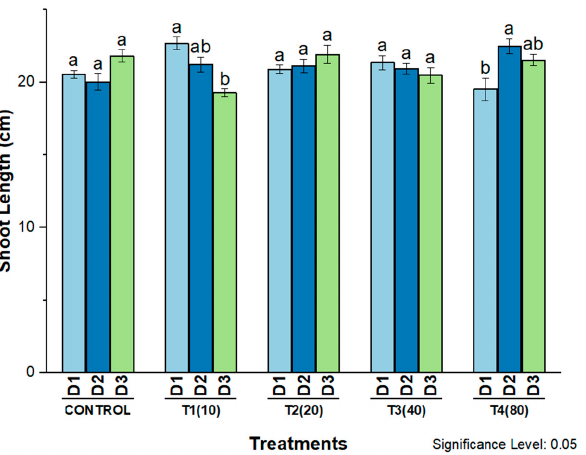
biomass. In contrast, only 80 mg/L AgNPs increased plant fresh weight on the second and third days after treatment compared to the other exposure levels and control plants (Figure 11).